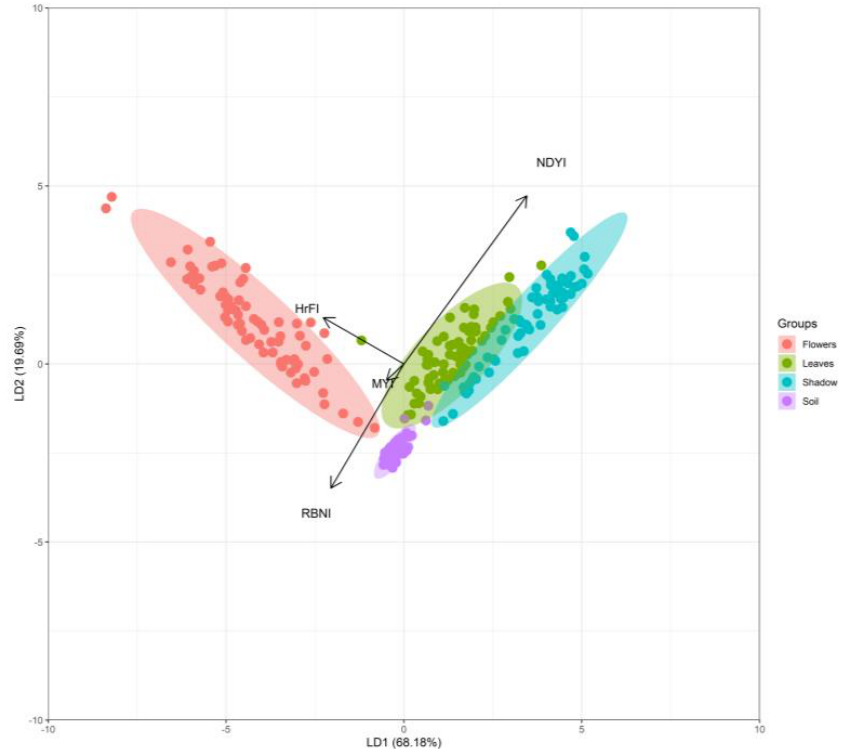
Figure 6. The bi-plot of the linear discriminant analysis (LDA) illustrating the separation between ground cover classes using four vegetation indices. HrFI: High-resolution Flowering Index, RBNI: Red Blue Normalizing Index, NDYI: Normalized Difference Yellowness Index, MYI: Modified Yellowness Index.